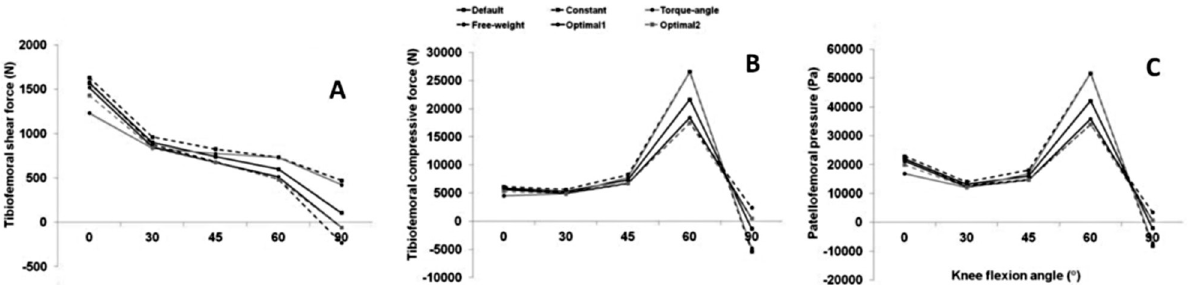
Figure 4 - A- Tibiofemoral shear force during knee extension. Results from the default machine, simulation of constant cam radius, torque angle profile (5), free-weight profile, and two optimized models (optimal 1 and optimal 2). B- Tibiofemoral compressive force during knee extension. Results from the default machine, simulation of constant cam radius, torque angle profile (5), free-weight profile, and two optimized models (optimal 1 and optimal 2). C- Pressure on the patellofemoral joint during knee extension. Results from the default machine, simulation of constant cam radius, torque angle profile (5), free-weight profile, and two optimized models (optimal 1 and optimal